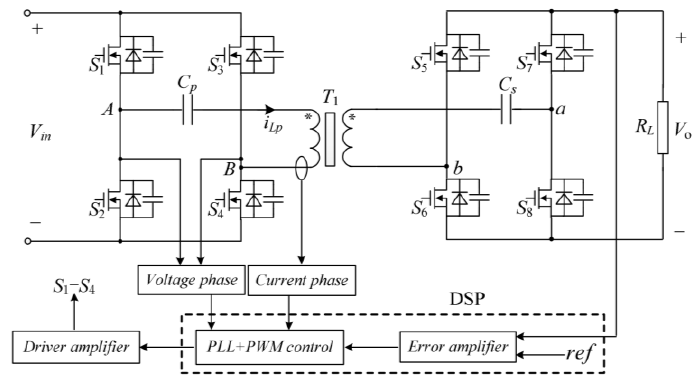
Figure 2. Dual active S–S IPTS with P-PLL&PWM control strategy [17].